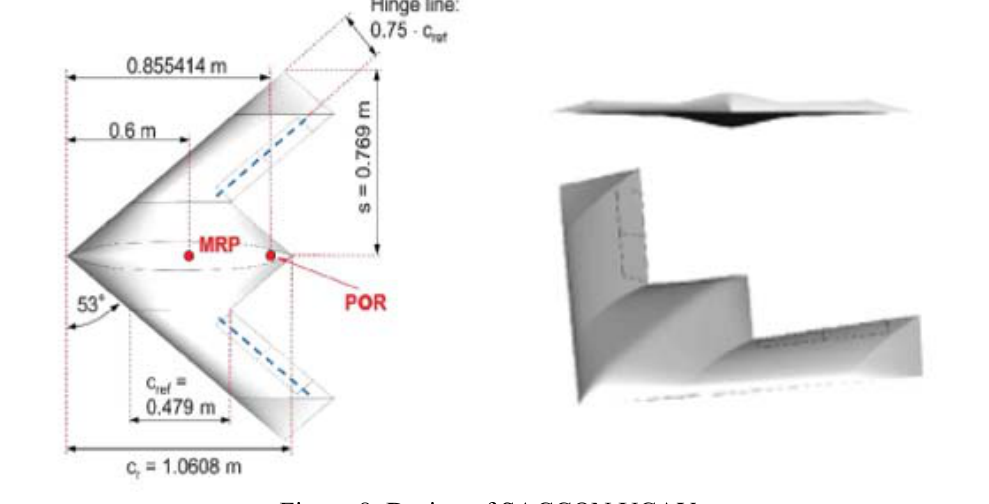
Figure 8. Design of SACCON UCAV